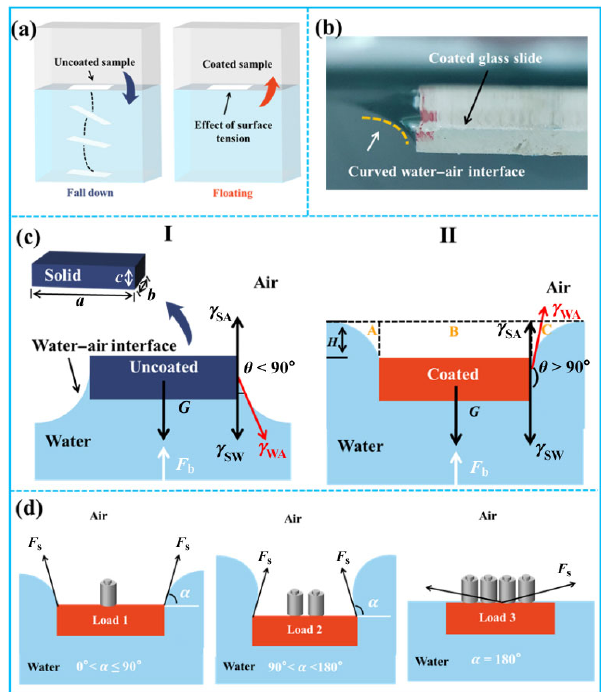
Fig. 8 Floating mechanism of a superhydrophobic body on the water surface based on surface tension. (a) Schematic diagram of the buoyancy test for uncoated and coated samples. (b) Optical image of top surface-coated glass slides floating on the water surface: cross-section. (c) Relationship between surface tension and wettability: hydrophilic and hydrophobic. F b denotes buoyant force. (d) Schematic diagram of hydrophobic objects pressing into the water